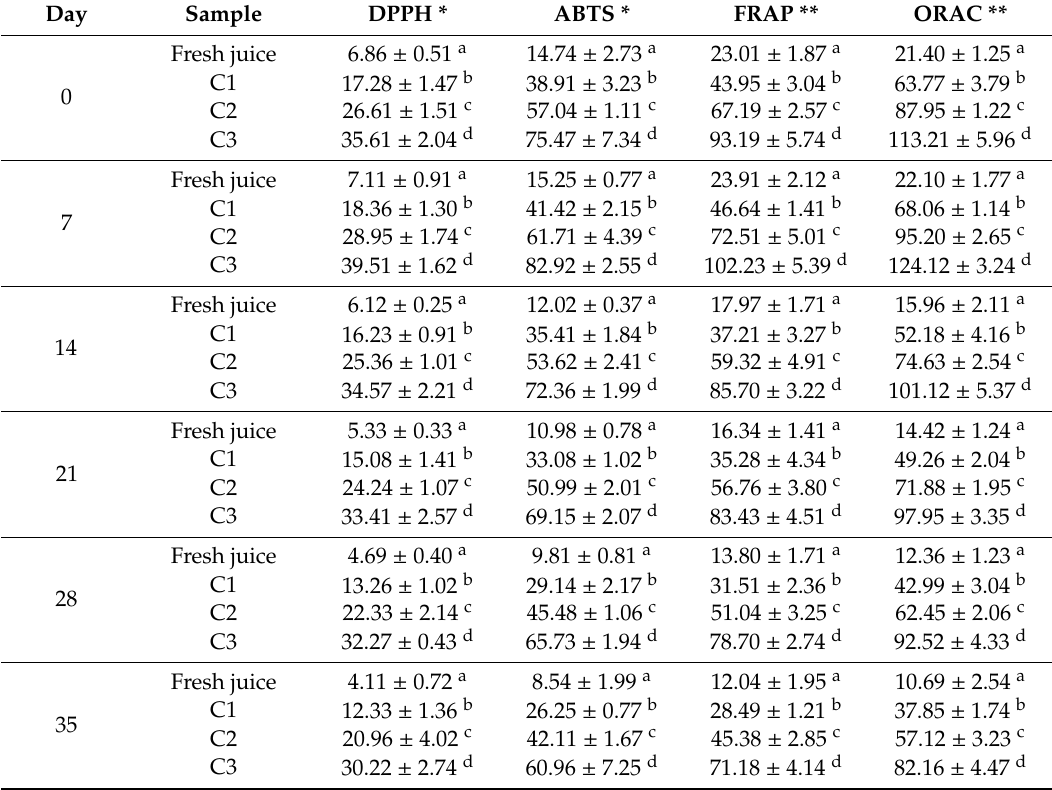
Table 5. Total antioxidant activity (TAA) values of fresh calafate juice and cryoconcentrate samples during storage.